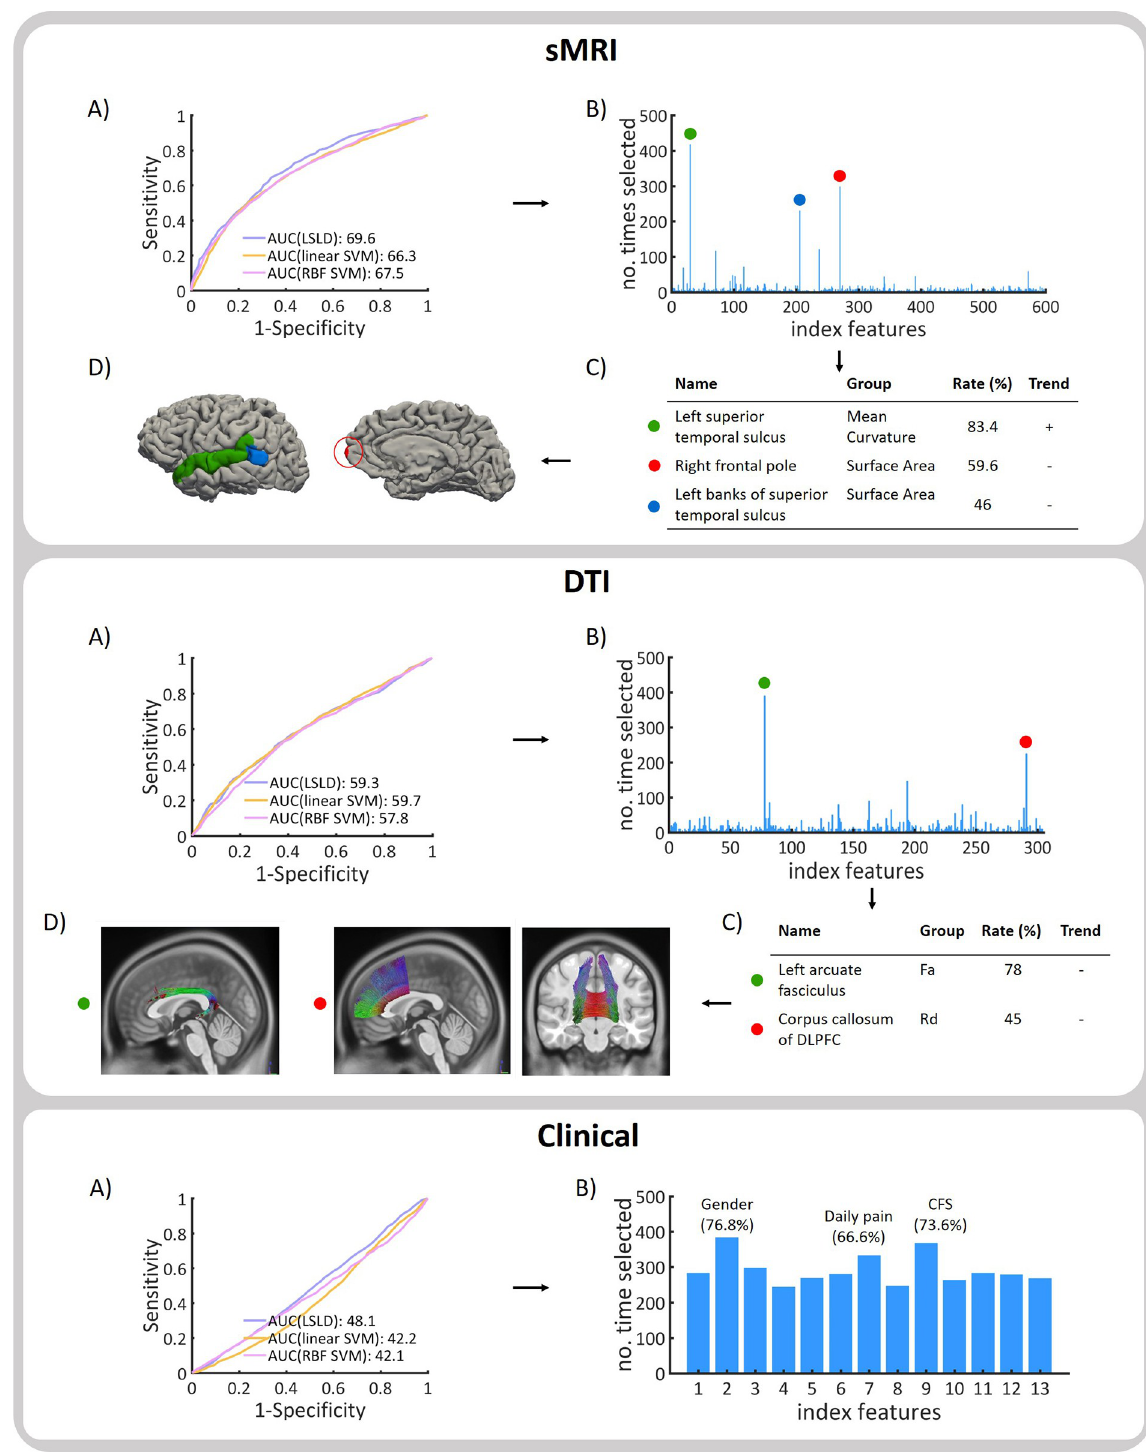
Fig 2. Classification results and most selected features. A) ROC curves and AUC values for three classifiers for 100 iterations of the CV procedure. B) Number of times each feature is selected during the feature selection for 100 iterations of the 5-fold CV procedure. C) Group: type of measure. Rate: frequency of repetition. Trend: +/- according to if the feature is increased/decreased in non-improvers compared to improvers of fatigue. Fa: fractional anisotropy. Rd: radial diffusivity. CFS: Chalder Fatigue Scale.